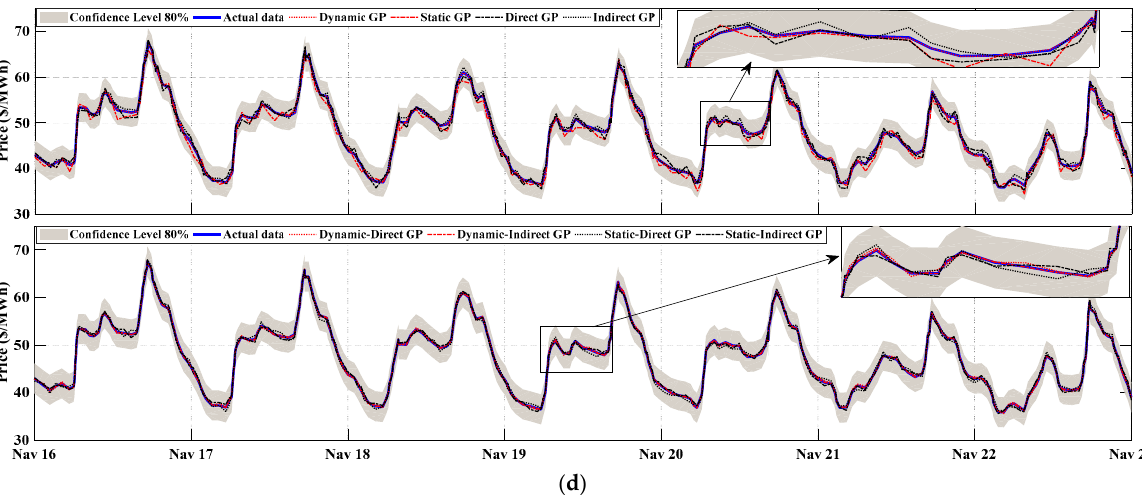
Figure 10. The forecasting of test data of EP using various models for the electricity market of the US: ( a ) winter, ( b ) spring, ( c ) summer, ( d ) autumn.